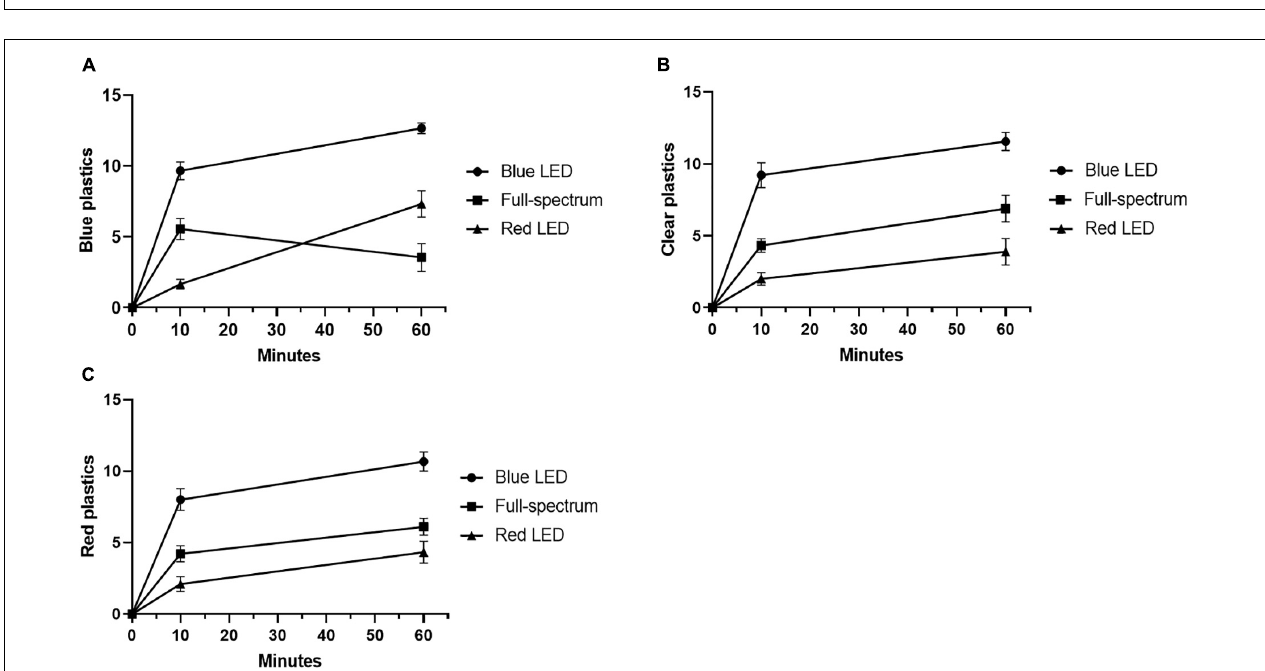
FIGURE 3 | The covering behavior of acrylic sheets in different colors. (A) The covering behavior of T. gratilla with (A) blue-, (B) transparent- and (C) red plastics at 10 and 60 min under different wavelength LED illumination. Each value represents mean ± SD.